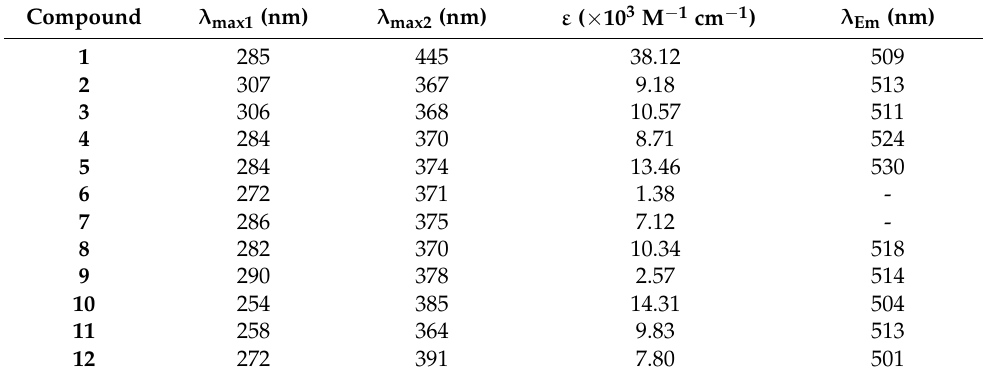
Table 1. Electronic absorption, molar absorptivity, and fluorescence emission maxima values in coumarin–thiadiazole hybrids 1-12 coumarin–thiadiazole hybrids 1-12.